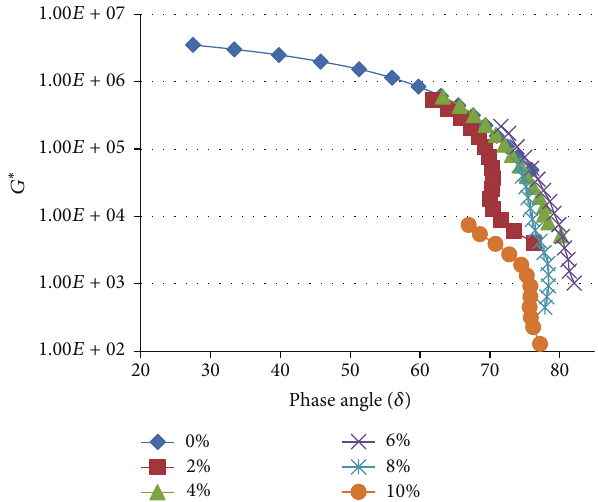
Figure 9: Black curves for WCO modified TLA blends measured